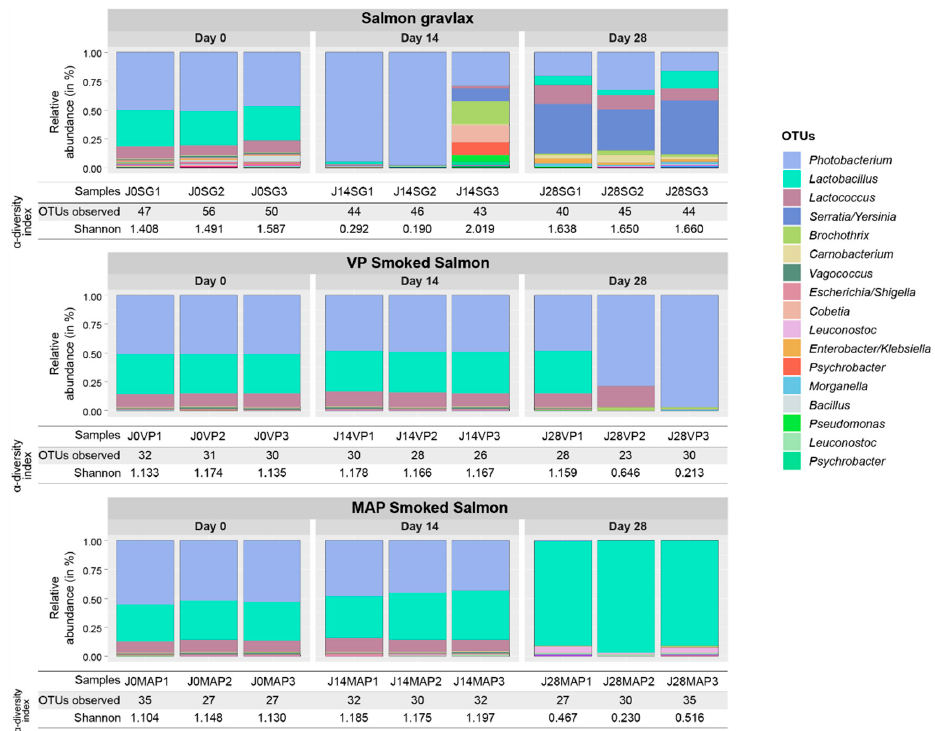
Figure 2. SG, MAP and VP CSS ecosystem relative compositions and α -diversities. Only OTU with a number of sequences representing more than 0.1% of the total number of reads appear in the legend and are ordered from the most abundant to the least abundant. The sample nomenclature is structured as follows: (1) sampling date, (2) type of sample (MAP, VP or SG) and (3) replicate number. For each sampling date, the experiments were done in triplicates.